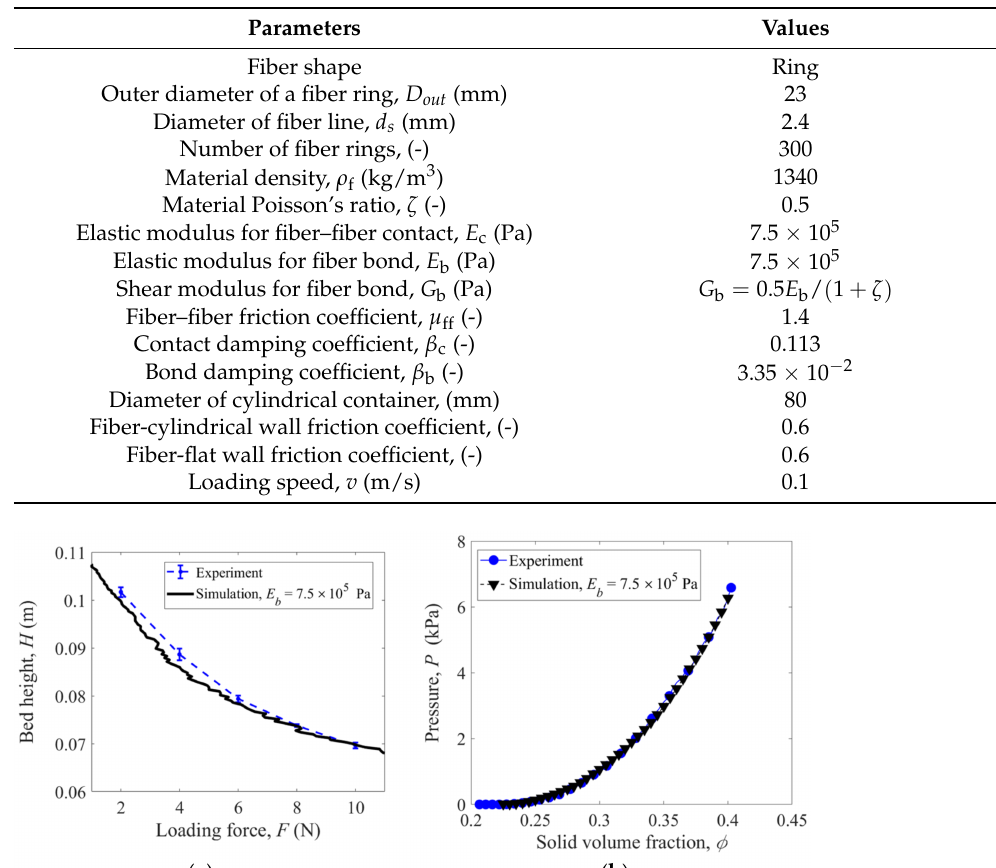
Figure 3. DEM simulation of the uniaxial compression of flexible rubber rings. Table 1. The parameters used in the simulations for the numerical model validation (rubber rings).